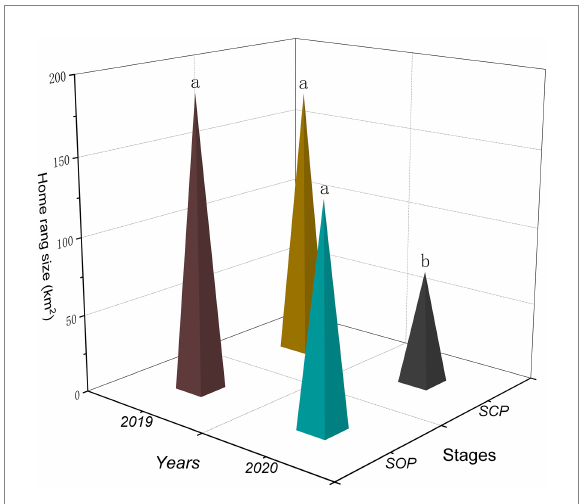
FIGURE 2 Wintering home range sizes (90%KDE) of black-headed gulls in different stages (SOP2019, SCP2019, COP2020, and SCP2020) at Dianchi Lake, Kunming City, Yunnan Province, southwestern China. Different letters (a, b) indicate significant differences in home range sizes among stages ( p ≤ 0.05), and the same letters indicate no differen ces ( p >